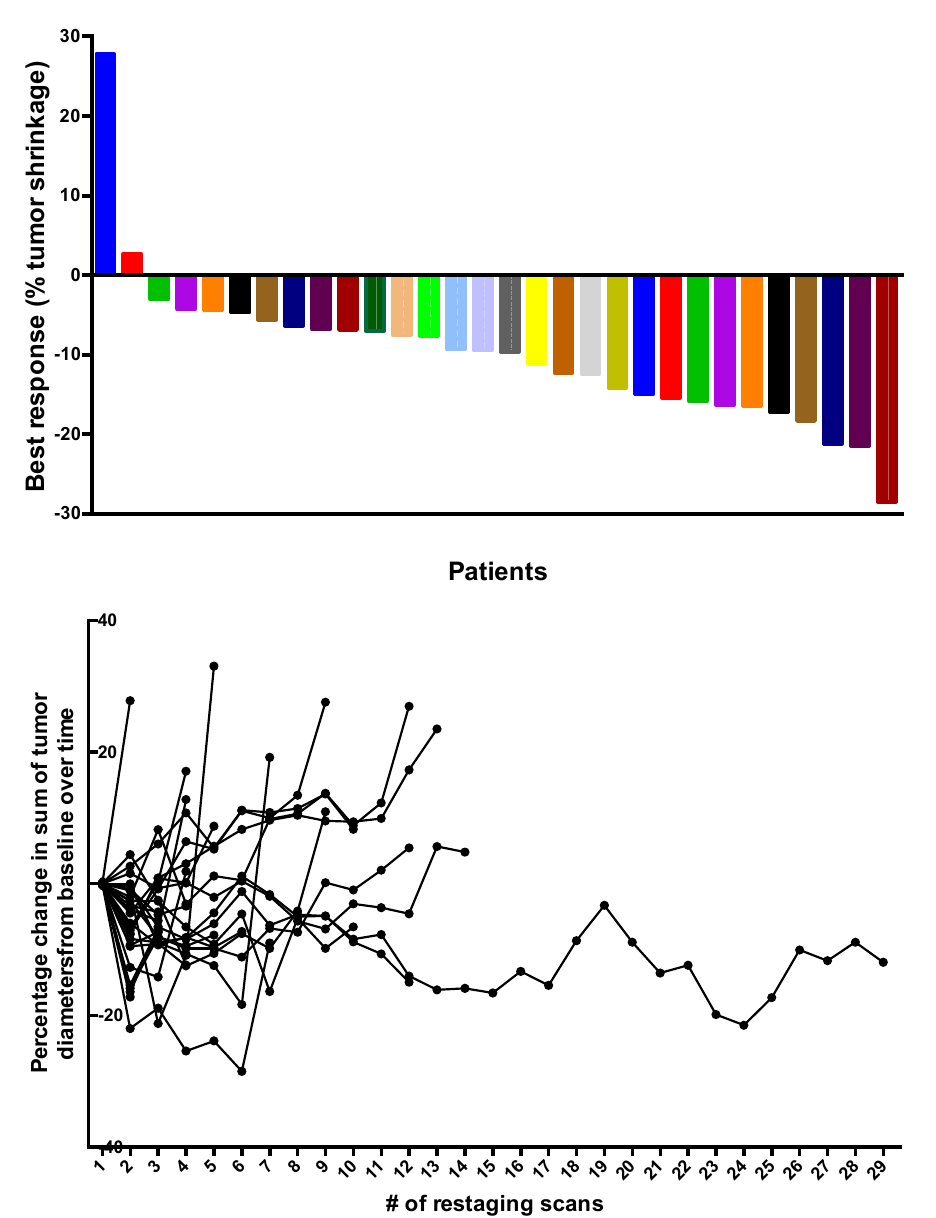
Figure 2. Top: Waterfall plot showing the best response on study measured as percentage change in sum of tumor diameters compared to baseline. Bottom: Spider plot of changes in tumor burden over time measured as percent change in the sum of target lesion diameters compared to baseline measurement at serial timepoints, corresponding to restaging scans obtained after every 2 cycles (8 weeks) for patients on the study. There was no patient meeting the objective response criteria according to RECIST 1.1 criteria (i.e., no patient experienced a tumor shrinkage of 30% or greater in the sum of the tumor target lesion diameters compared to baseline measurements) and the majority of patients achieved stable disease as best outcome.